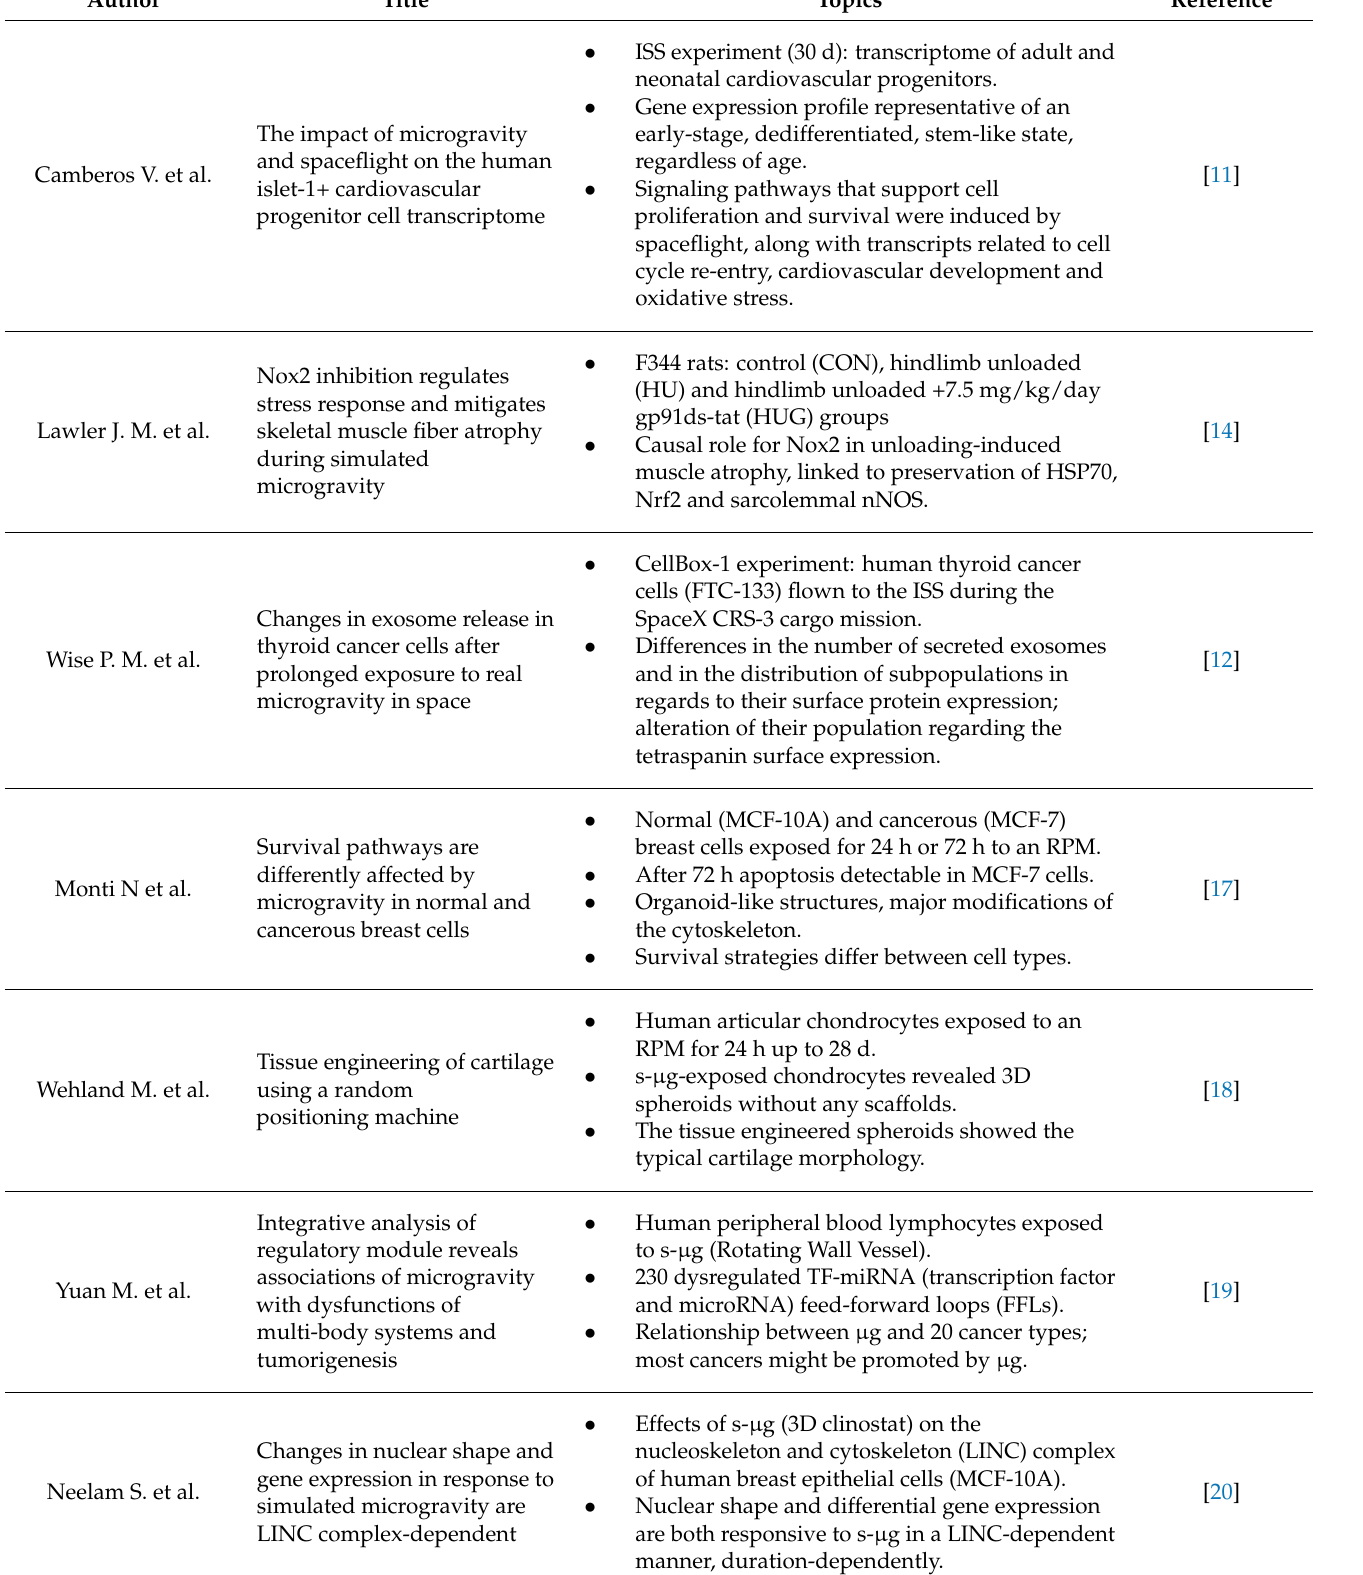
Table 1. Research articles contributed to the Special Issue “Microgravity and Space